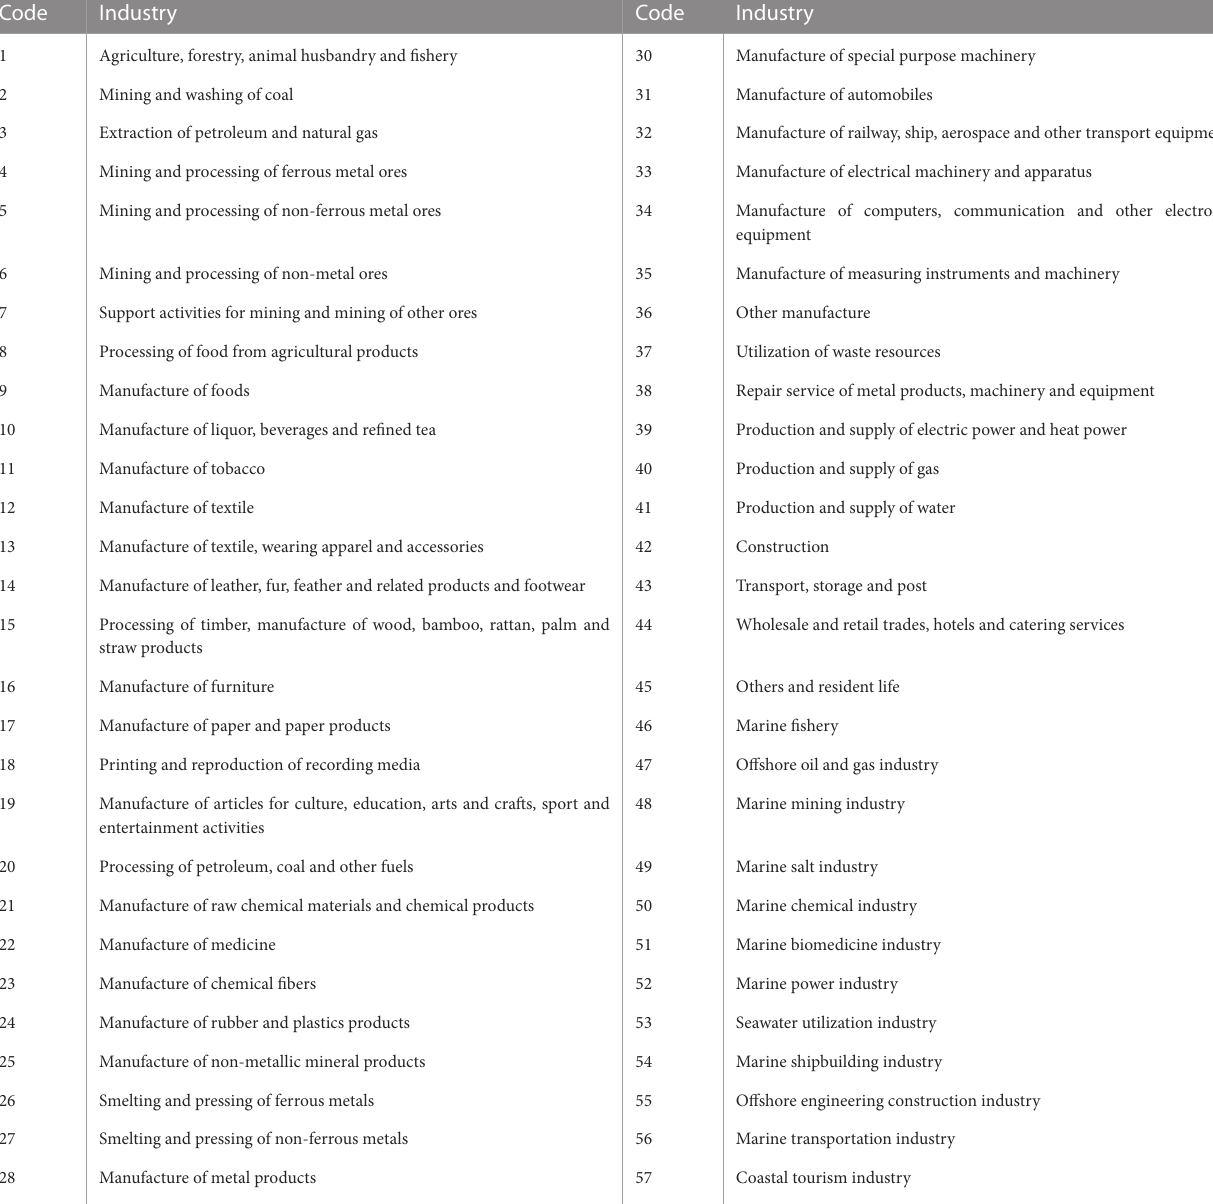
TABLEA1 Final industry division and code